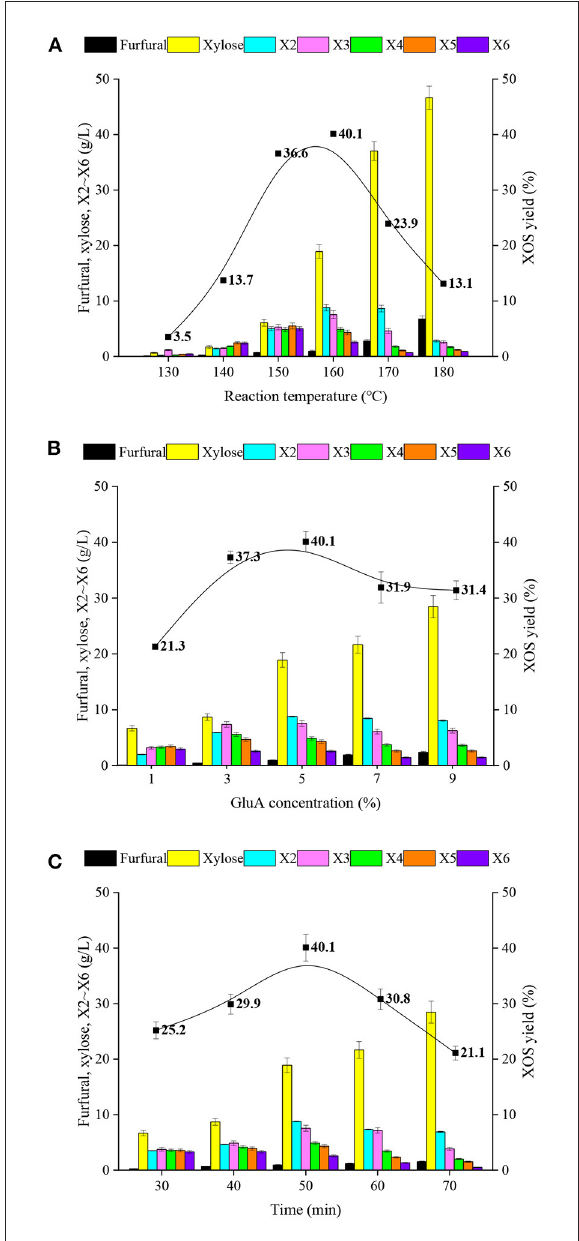
FIGURE1 The effects of (A) reaction temperature, (B) GluA concentration and (C) hydrolysis period for the products, including the content of furfural, xylose, X2-X6, and the yields of XOS in GluA-hydrolysate of xylan. X2, xylobiose; X3, xylotriose; X4, xylotetraose; X5, xylopentaose; X6, xylohexaose; XOS, xylooligosaccharides.